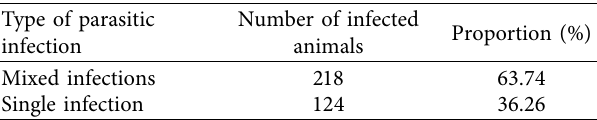
Table 2: Proportion of infection